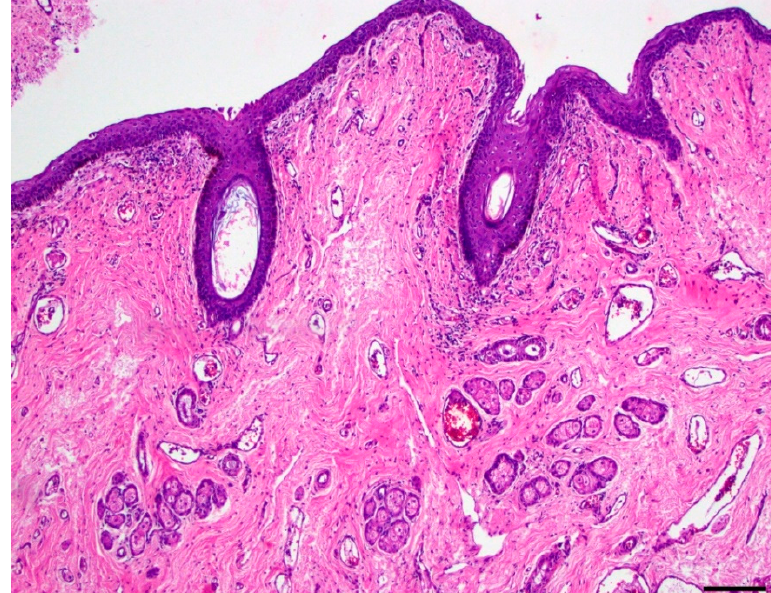
Figure 3. Dermoid cyst (100x, hematoxylin and eosin). The lumen is multifocally lined by non-keratinizing, stratified squamous epithelium. The supporting fibrovascular stroma contains few hair follicles, moderate numbers of sebaceous glands and fewer apocrine glands; bar = 200 µm.